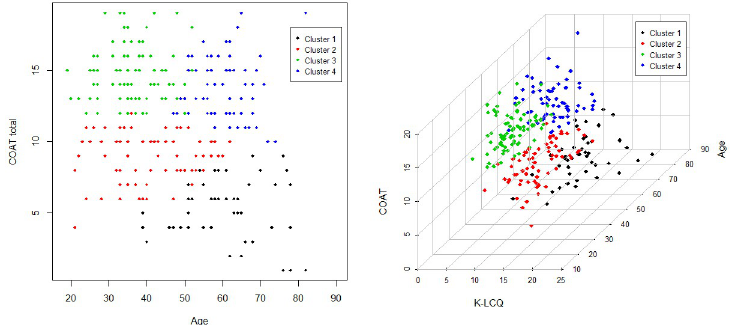
Fig 2. Distribution of each of the 4 clusters by age and COAT score (A) and a 3-dimensional plot including the K-LCQ score (B). (A) X and Y axis mean age and COAT total score (B) X, Y, Z axis mean K-LCQ, age, and COAT score, respectively. Cluster analysis was performed by the K-prototype clustering using the clustMixType package. Different colour indicates each cluster (black: cluster 1, red: cluster 2, green: cluster 3, and blue: cluster 4).